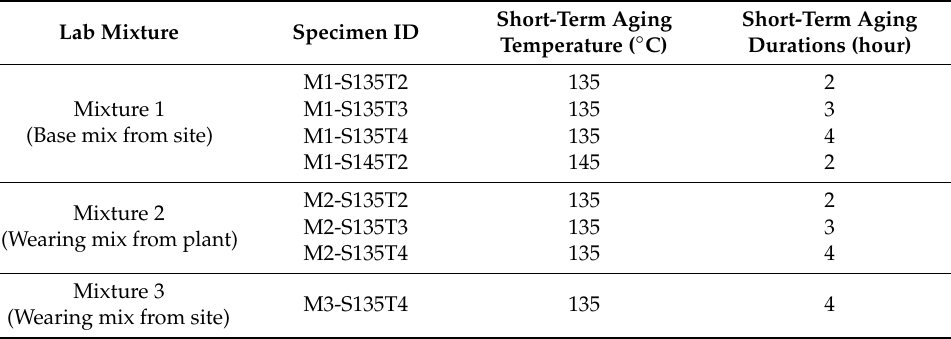
Table 2. Testing program details for laboratory